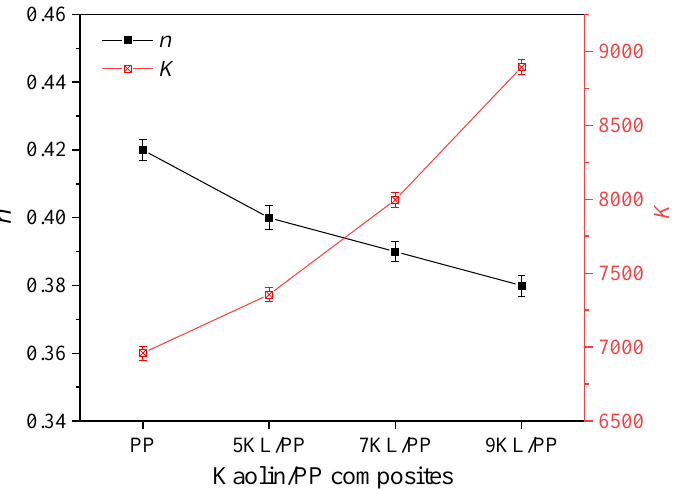
Figure 3. Microscopy non-Newton index and consistency coefficient of the kaolin/PP composites.